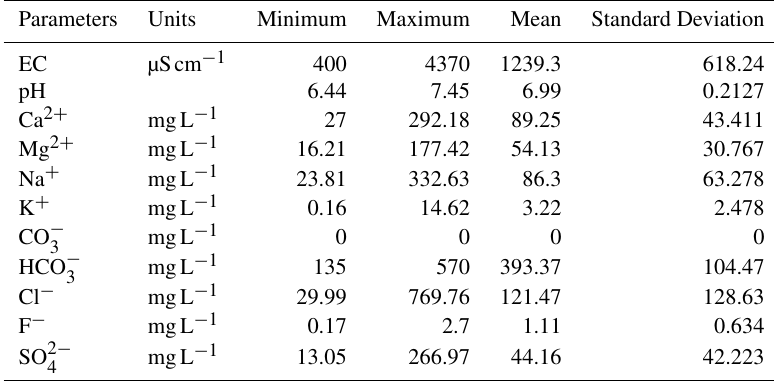
Table 3. Minimum, Maximum and Statistical values of water parameters.